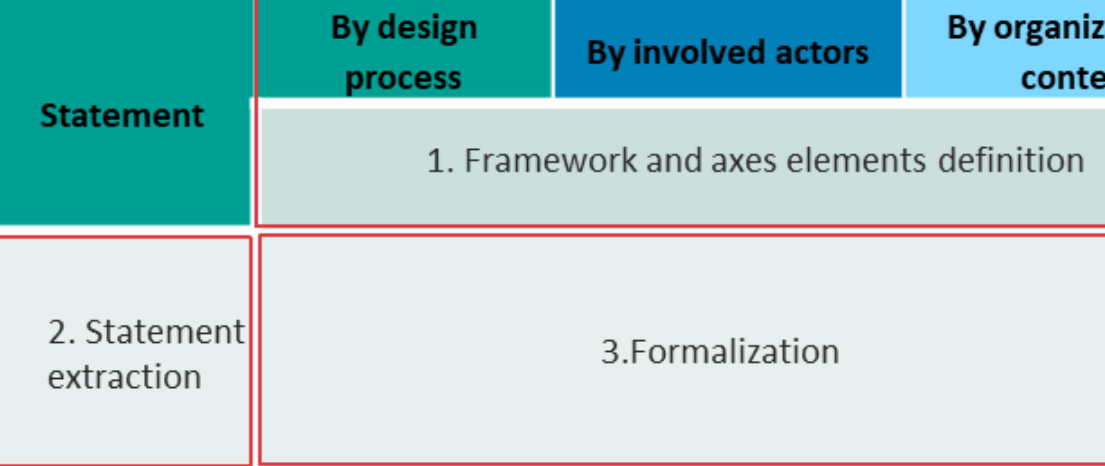
Figure 3. General structure of the knowledge base.